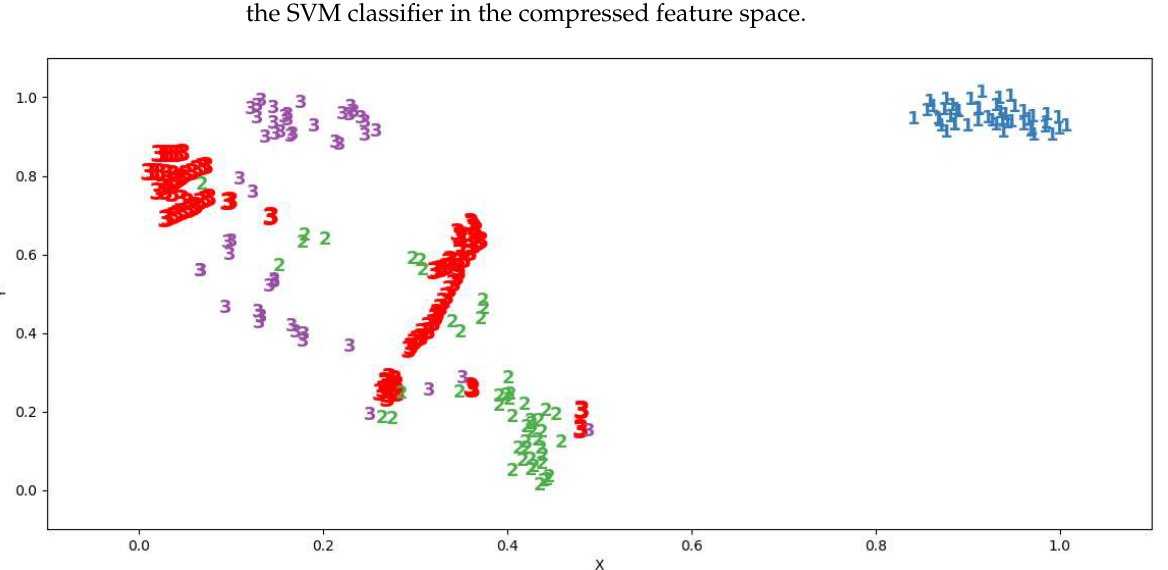
For clarity, Figure 8 shows the training sample and successful adversarial attacks on the SVM classifier in the compressed feature space.